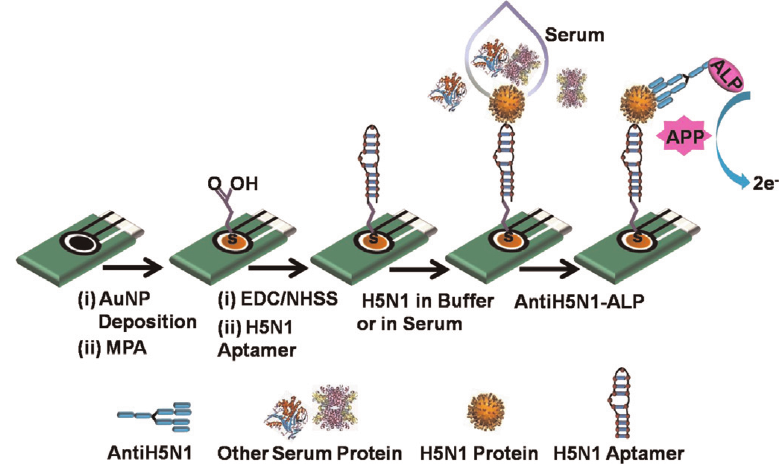
Figure 24. Illustration of the amperometric H5N1 detection sensor [69]. reaction of the substrate APP with the surface formed aptamer/H5N1/antiH5N1- Table 1 Virus strains used in this study and the detection limits of AC-ELISA. ALP on a Au NP modi fi ed screen printed carbon electrode. A DNA aptamer probe Serotype speci fi c to H5N1 was covalently immobilized onto the MPA functionalized Au NPs on the electrode surface through EDC/NHSS cross-linking chemistry. The speci fi c adsorption of H5N1 protein and ALP tagged antiH5N1 onto the DNA aptamer surface was then detected via the APP redox reaction. All steps are described in